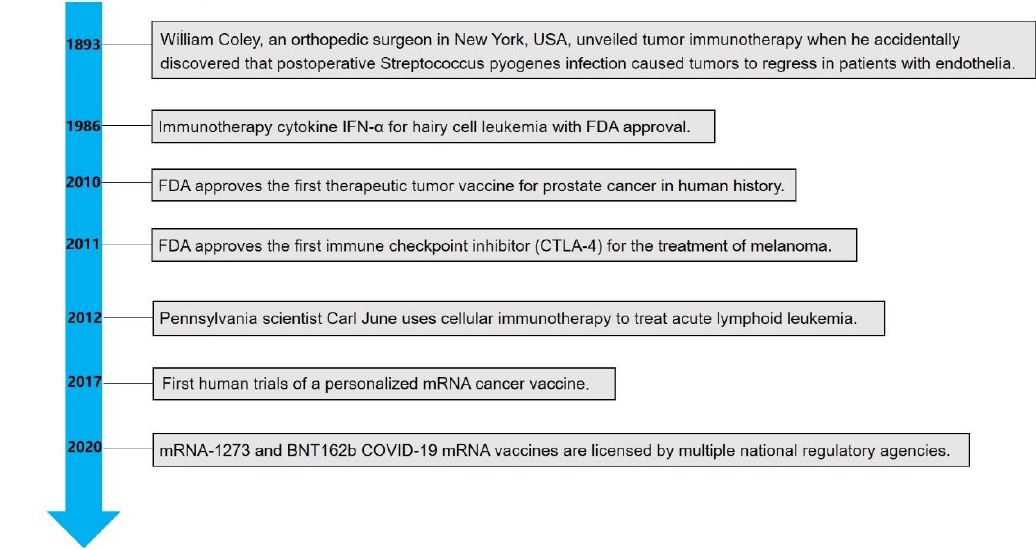
Figure 2. Timeline of some key milestones for cancer immunotherapy development.